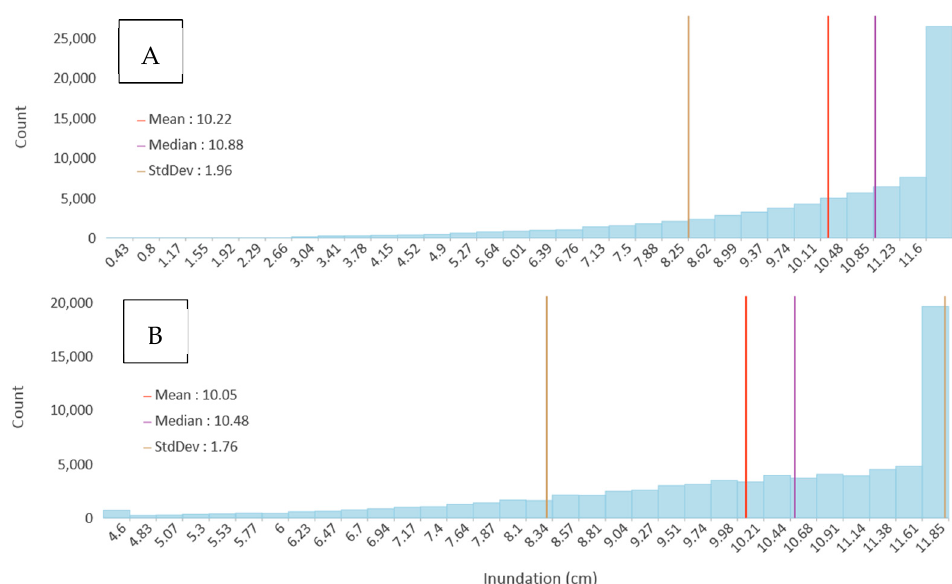
Figure 10. The frequency of runoff depths for all subbasins in Philadelphia, estimated by the ( A ) NRCS and ( B ) modified rational models for 24-hour, 10-year storm.